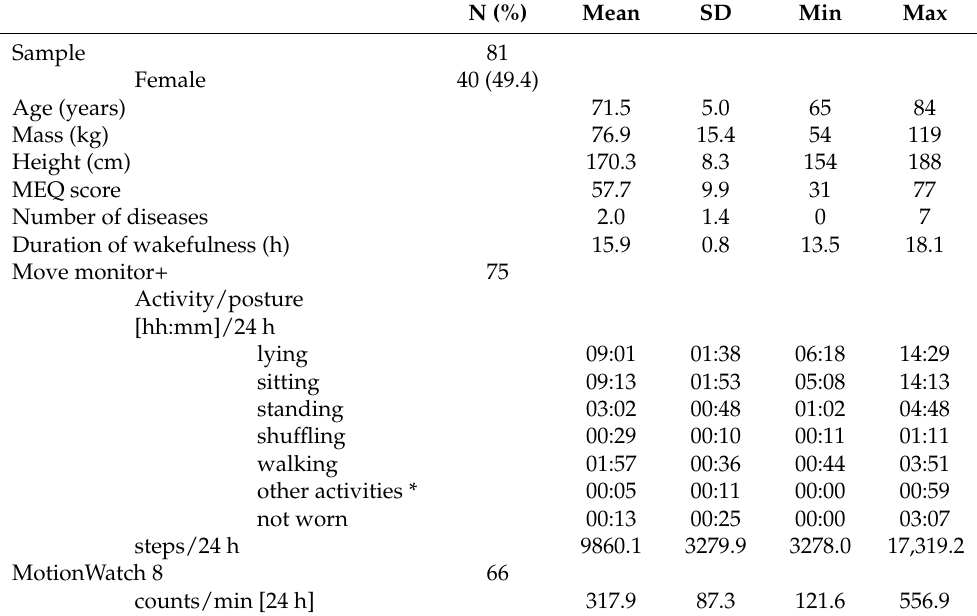
Table 1. Sample characteristics.